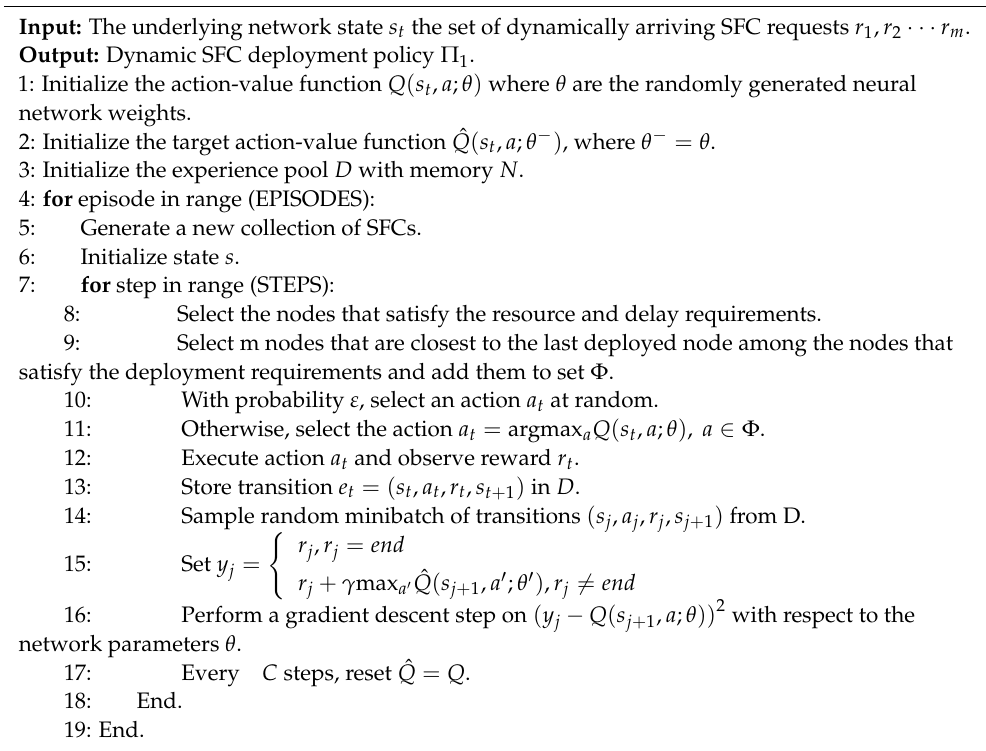
Algorithm 1: DQN-based dynamic SFC deployment